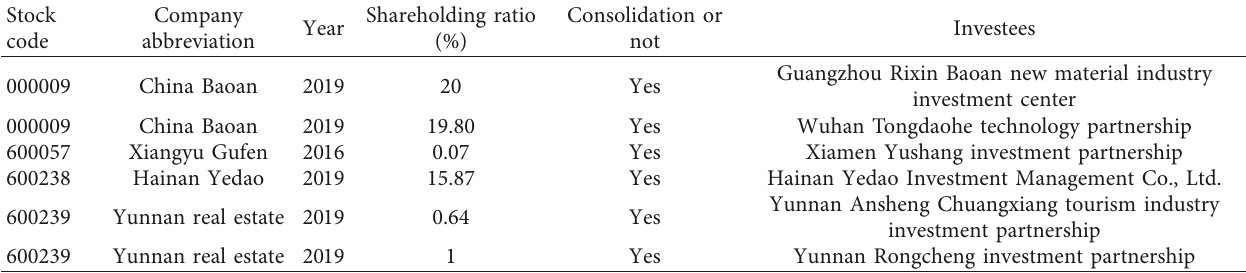
Table 1: Statistics of the relationship between shareholding ratio and consolidation (shareholding ratio < 30%). Stock